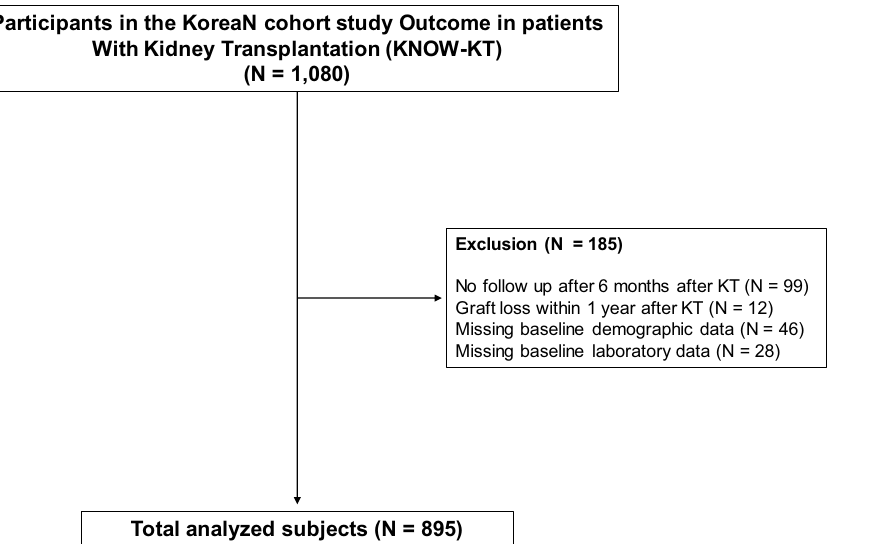
Figure 3. Flow diagram of the study cohort. KT kidney